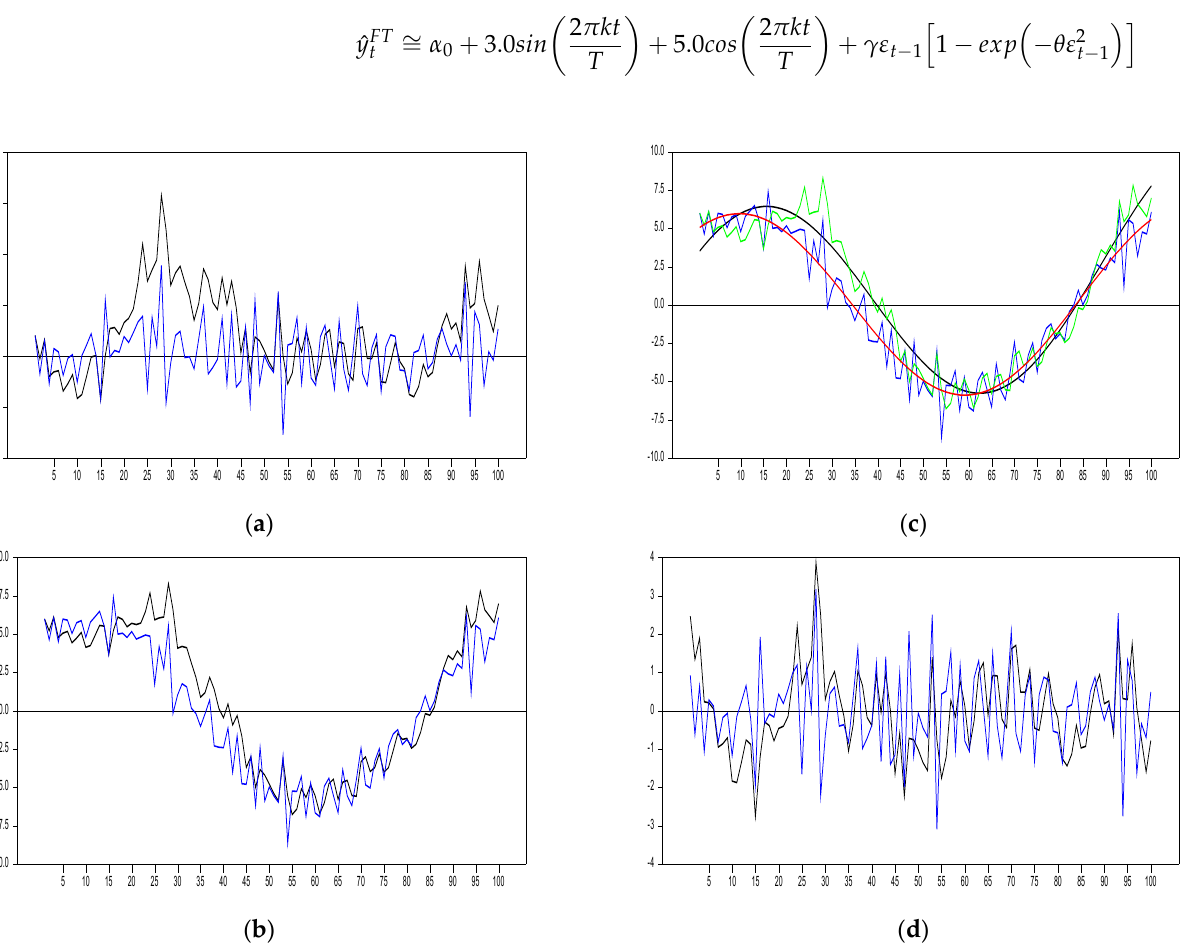
Figure 1. Non–linearity around smooth break and the behaviour of low frequency Fourier transforms. In Figure 1, Panel (a), the blue series is an AR(1) stationary process while the black series is the stationary ESTAR (1) process. In Panel (b), the same Fourier function has been added to these two processes with the same colours. In Panel (c), trend functions were found using the grid search method described in Enders and Lee [1] in these two series.